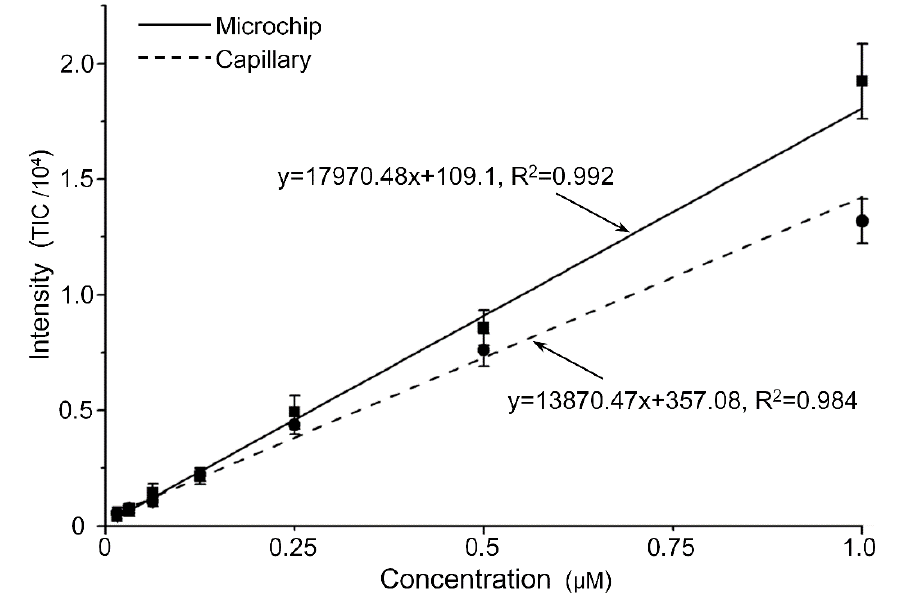
Figure 7. Different signal intensities of sample solutions in different concentrations. Each point represents the mean value of signal data and error bar for the deviation at each